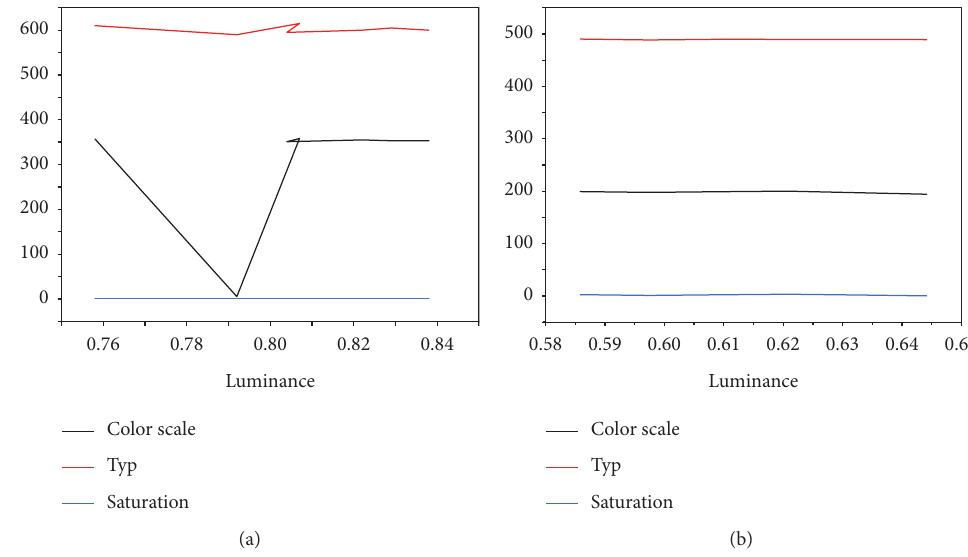
Figure 9: Test data of different brightness under different color LED lamps. (a) red LED light; (b) blue LED light.